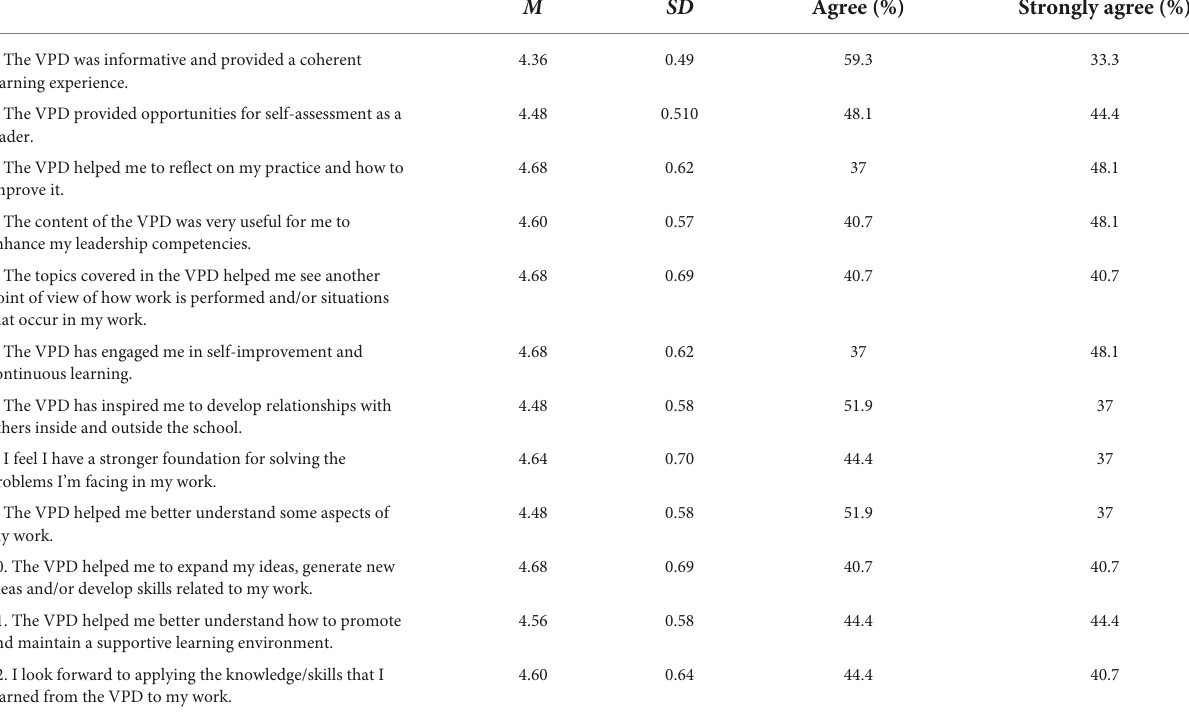
TABLE 1 Descriptive statistics of the overall effectiveness of the